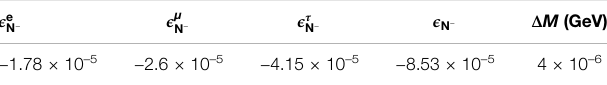
TABLE 3 | CPasymmetriesand masssplittingobtained from the allowed range of model parameters which satisfy neutrino oscillation data.  e N −